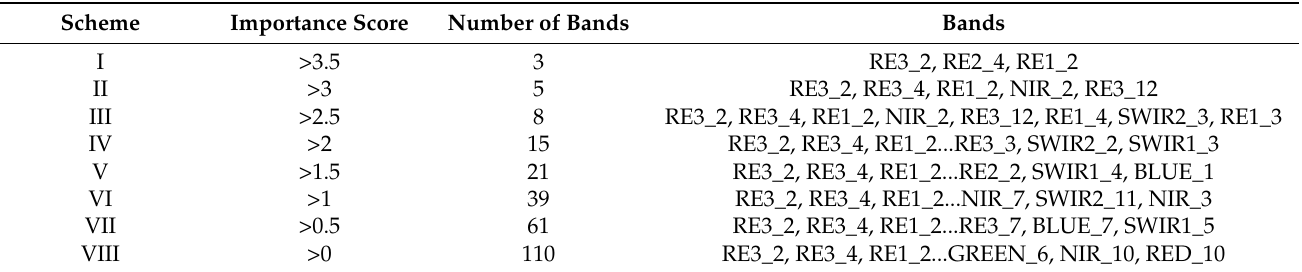
Table 3. The information of different multi-temporal schemes.